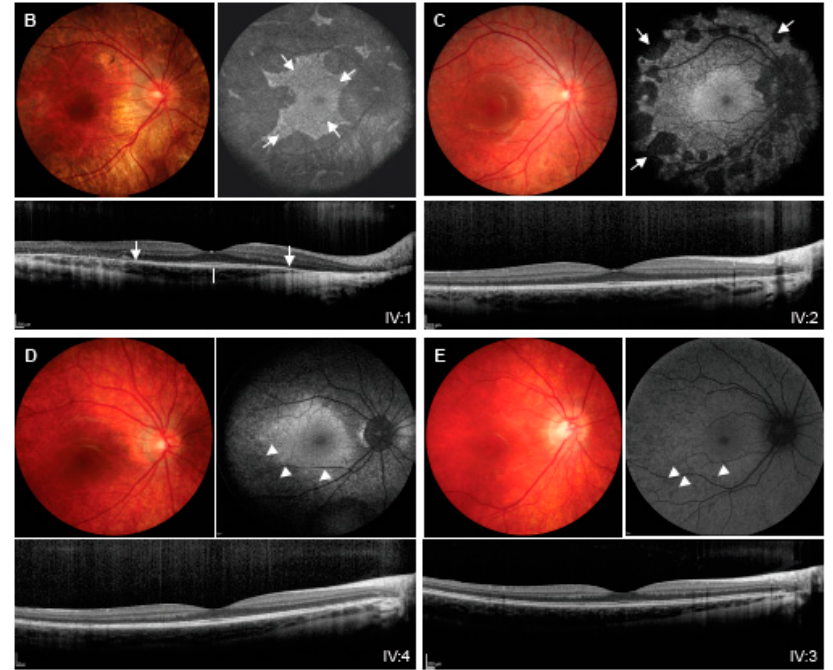
Figure 1. Family history and clinical phenotype . ( A ) Pedigree indicating males affected with choroideremia (filled symbols), carrier females (symbols with a dark dot) and unaffected individuals (open symbols). Diagonal lines indicate deceased individuals. In generation II, grey symbol indicates an individual who was reported as blind due to diabetes mellitus. The numbering of individuals in this generation is not continuous, as four additional siblings who died in childhood have not been indicated on the pedigree. The proband, (individual IV:1; CHM4) is indicated by an arrow. Disease-associated haplotypes are indicated by black rectangles and normal haplotypes by white rectangles. A recombination between the normal and CHM allele (black and white rectangles) appears to have occurred. AR — polymorphic marker in the gene encoding the androgen receptor. DXS8076 and DSX1002 — polymorphic markers flanking the CHM gene. I-14 — single tandem repeat in intron 14 of CHM. ( B ) Multimodal imaging of the right eye of the 18 year-old proband IV:1. Upper left panel, fundus photographs showing the scalloped chorioretinal atrophy of the mid-periphery and preserved appearance of the posterior pole. Upper right panel, fundus autofluorescence highlighting the string-like pattern of the preserved macular area (white arrows) that contrasts with the dark appearance of the peripheral chorioretinal atrophy. Lower panel, SD-OCT scan showing a preserved ellipsoid zone at the posterior pole that is delimited by the two arrows. On the peripheral part of the scan, the ellipsoid zone vanishes and the outer nuclear layer is thinner. The white bar indicates the thinning of the choroid beneath the fovea. ( C ) The younger brother (VI:2; CHM5) at 14 years of age. Upper left panel, funduscopy showing a salt and pepper pattern of the mid-periphery of the retina. By autofluorescence imaging (upper right panel), the atrophic patches are better identified as they appear black (white arrows) and contrast with the preserved posterior pole. By SD-OCT, the ellipsoid zone is identifiable on the entire scan. ( D ) The youngest brother (IV:4) at 9 years of age with early stage lesions. Upper left panel, typical multiple mottling of the retinal pigment epithelium can be seen in the mid-periphery of the fundus. Upper right panel, autofluorescence imaging discloses multiple small hypo-autofluorescent dots (arrowheads) but no complete atrophic lesions. The posterior pole is preserved and has an almost normal appearance on the SD OCT scan (lower panel). ( E ) The asymptomatic heterozygous sister (IV:3) with a typical reticular pattern of pigmentary mottling of the retinal pigment epithelium (upper left panel) and hypo-autofluorescent thin dots or speckles (arrowheads) in the mid-periphery and outer part of the posterior pole (upper right panel). There are no significant lesions detectable on the SD-OCT scan (lower